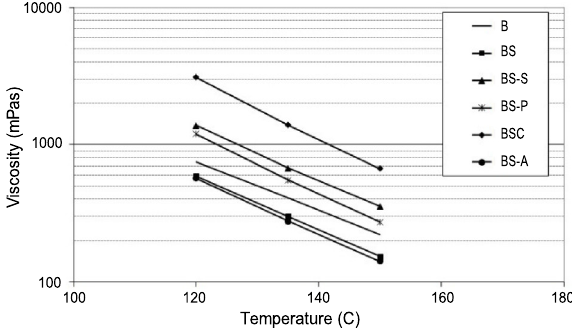
Fig. 5. Dynamic viscosity curves of modified